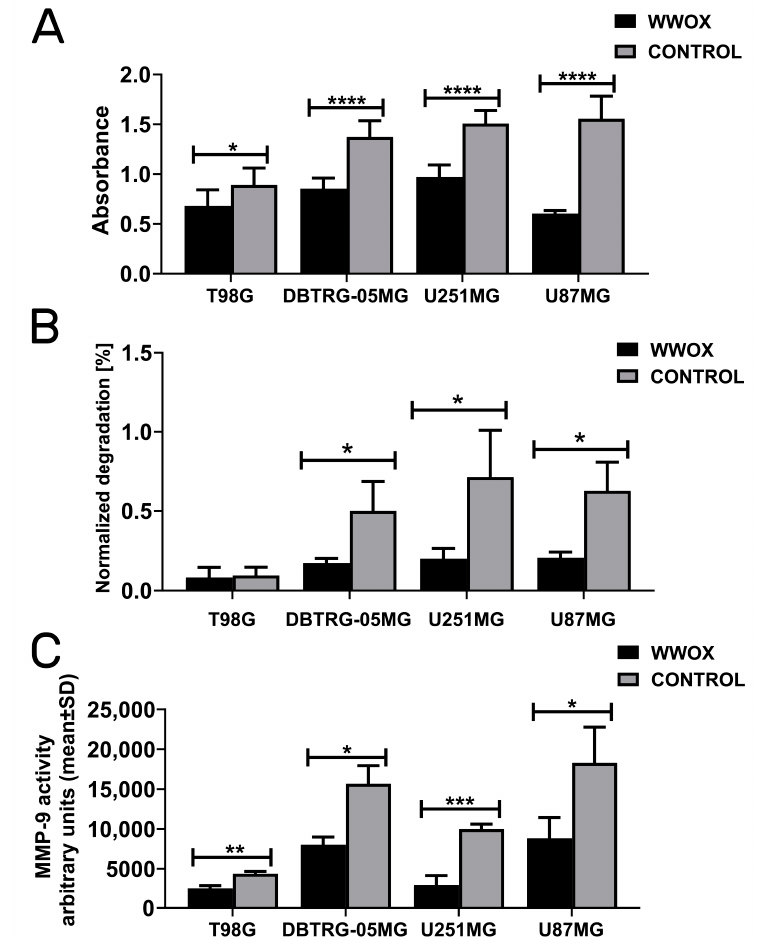
Figure 5. Determining the invasiveness, gelatin degradation, and MMP-9 activity. ( A ) Invasion assay. ( B ) Gelatin-layer degradation. ( C ) MMP-9 activity. p < 0.05 (*), p < 0.01 (**), p < 0.001 (***), p < 0.0001 (****).